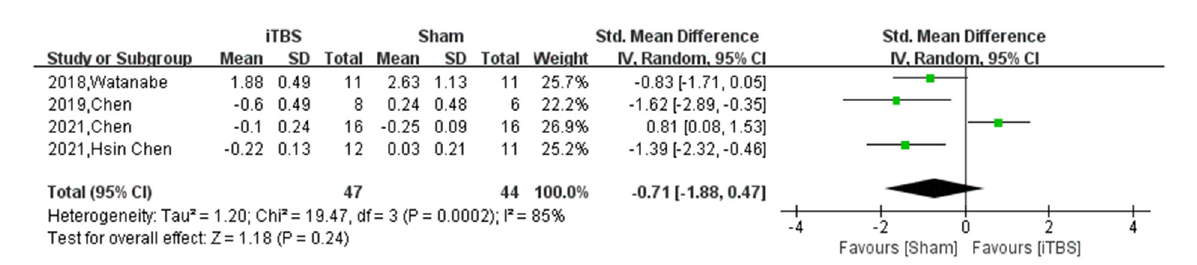
FIGURE4 The pooled Std.MD of MAS change from baseline. The green square indicates the estimated Std.MD for each RCT. The size of the green square indicates the estimated weight of each RCT, and the extending lines indicate the estimated 95% CI of Std.MD for each RCT. The black diamond indicates the estimated Std.MD (95% CI) for all